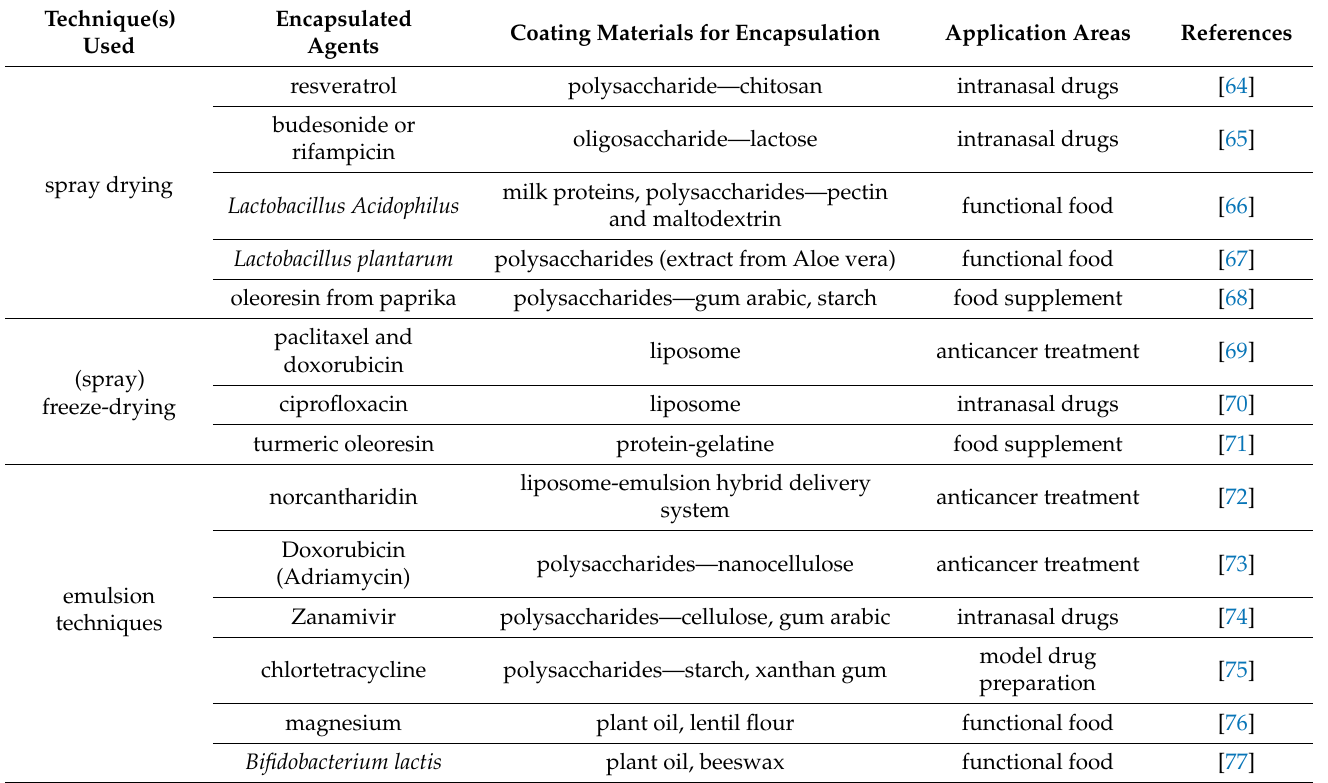
Table 1. Recently published preparations of systems with encapsulated agents using different